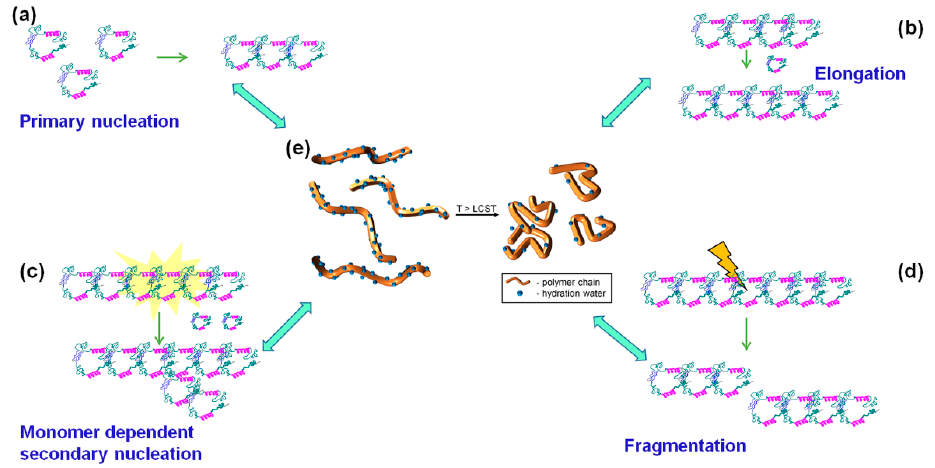
Figure 1. Molecular events during the lag time ( a – d ): ( a ) primary nucleation; ( b ) elongation; ( c ) monomer-dependent secondary nucleation; ( d ) fragmentation creates new elongation sites in the system; and ( e ) transition of a thermoresponsive polymer from the hydrated coil to the collapsed state. Prior to heating, the polymer chain (brown) is more hydrated. When the cloud point temperature ( T CP ) has been reached, the chain collapses to a compact globule by releasing most of the hydration water (blue), and further aggregation of the collapsed chains is possible [3,12–16]. LCST: lower critical solution temperature.